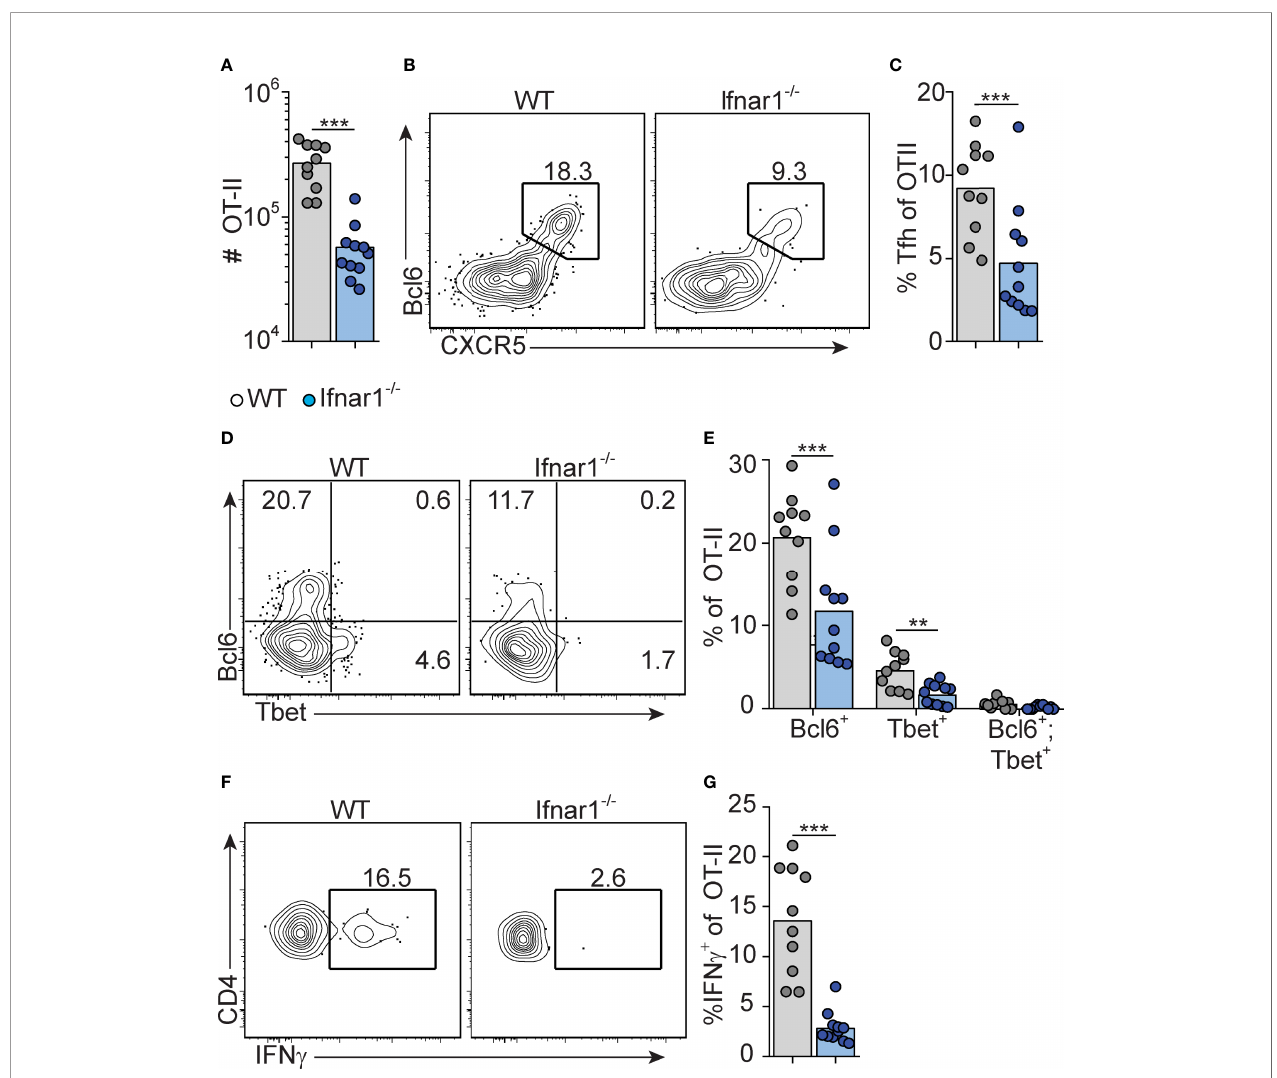
FIGURE 2 | Type I IFN signaling augments Tfh and is required for Th1 cell differentiation. WT and Ifnar1 -/- mice were transferred with 5000 OT-II cells and immunized with OVA/pI:C. Donor B220 - CD4 + CD45.2 + OT-II cells in spleens were analyzed by fl ow cytometry 8 dpi. (A) Number of OT-II cells. (B, C) Quanti fi cation of CXCR5 + Bcl6 + Tfh cells. Representative contour plots (B) and pooled results of percentages of Tfh cells (C) . (D, E) Analysis of Bcl6 versus T-bet expression. Representative contour plots (D) and pooled results of percentages of OT-II cells displaying single- or co-expression of Bcl6 and T-bet, respectively. (F, G) IFN- g expression. Representative contour plots (F) and pooled results of percentage of OT-II cells expressing IFN- g (G) . Results are pooled from three individual experiments and each symbol represents one mouse. **p<0.01 and